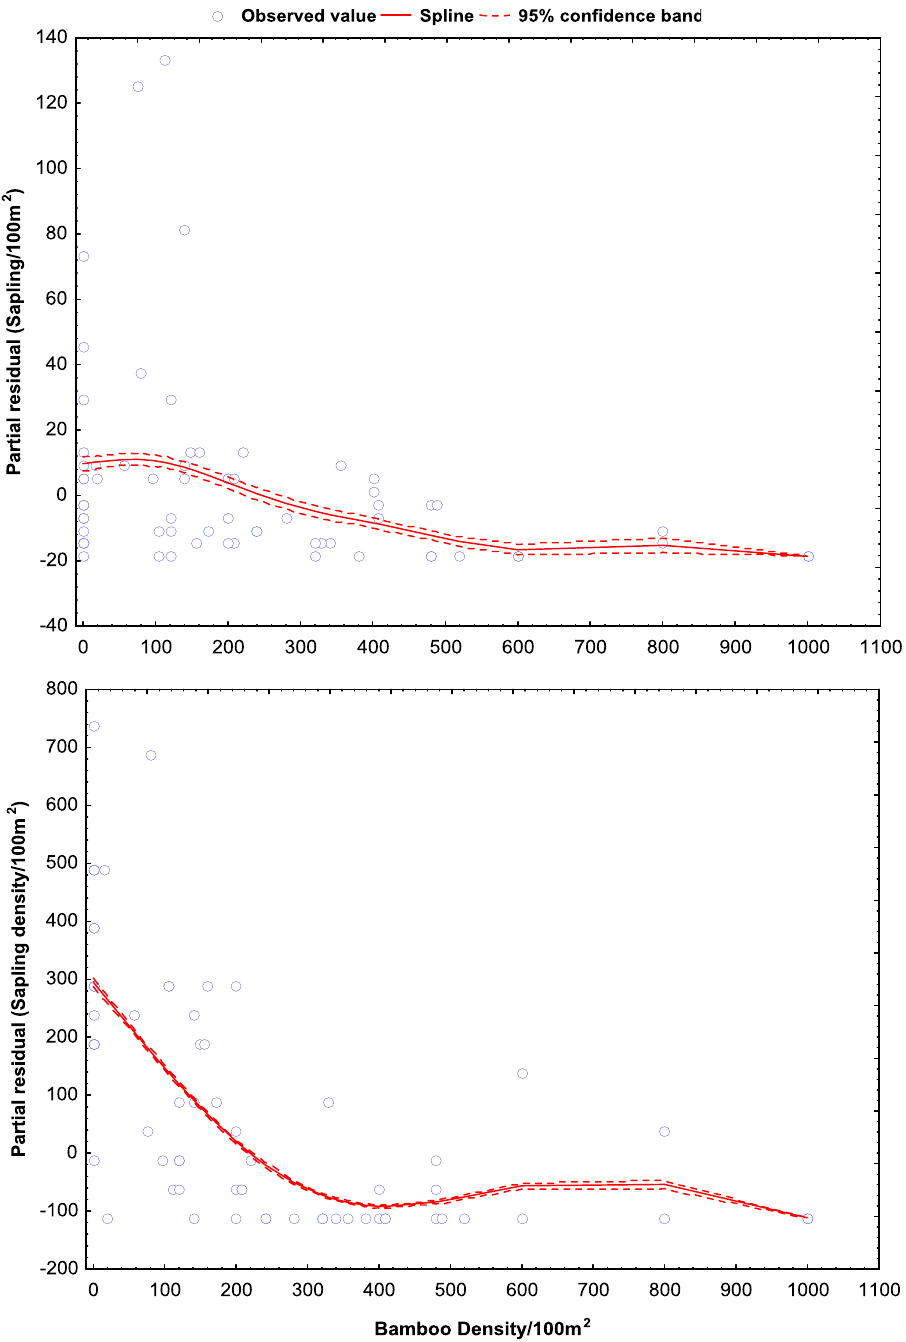
Figure 4. Predicted changes in density of tree sapling and seedlings with respect to increasing density of bamboo. The significance of the smooth best fit model generalized the changing slope as GAM coefficient (β), standard error (SE), coefficient of determinant (R 2